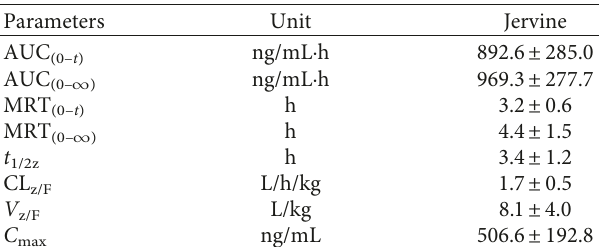
Table 2: The main pharmacokinetic parameters of jervine after intravenous